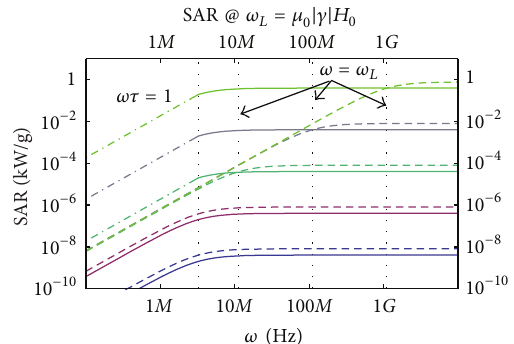
Figure 7: (colour online) Specific absorption rate as a function of frequency 𝜔 . Notation as under Figure